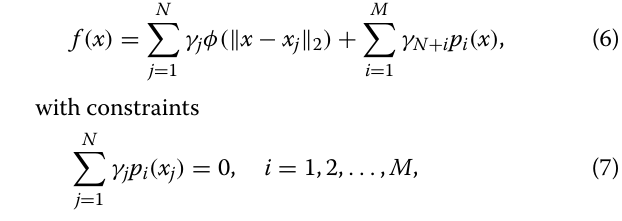
Table 1 [ k ] denotes the nearest integers less than or equal to k , and N the natural number, c a positive constant which is known as the shape parameter, and CPD denotes the m-order conditionally positive definite functions [3, 11] Name of RBF Definition Multiquadric